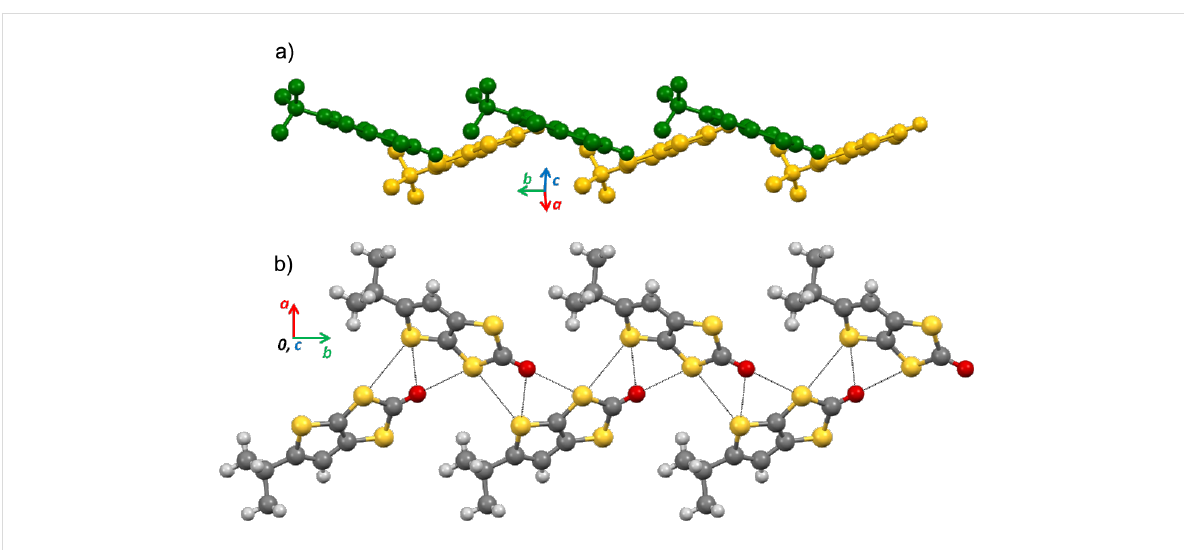
The crystal structure is composed of pairs of side-by-side chains of ketone 1 running parallel to b . Within these bi-chains, the molecules are connected by short S … S and S … O interactions with the tert -butyl groups pointing outside, in a herringbone fashion (Figure 3b). Molecules in different chains make an angle of circa 39° (Figure 3a). There are no close contacts between bi-chains (Figure 4).